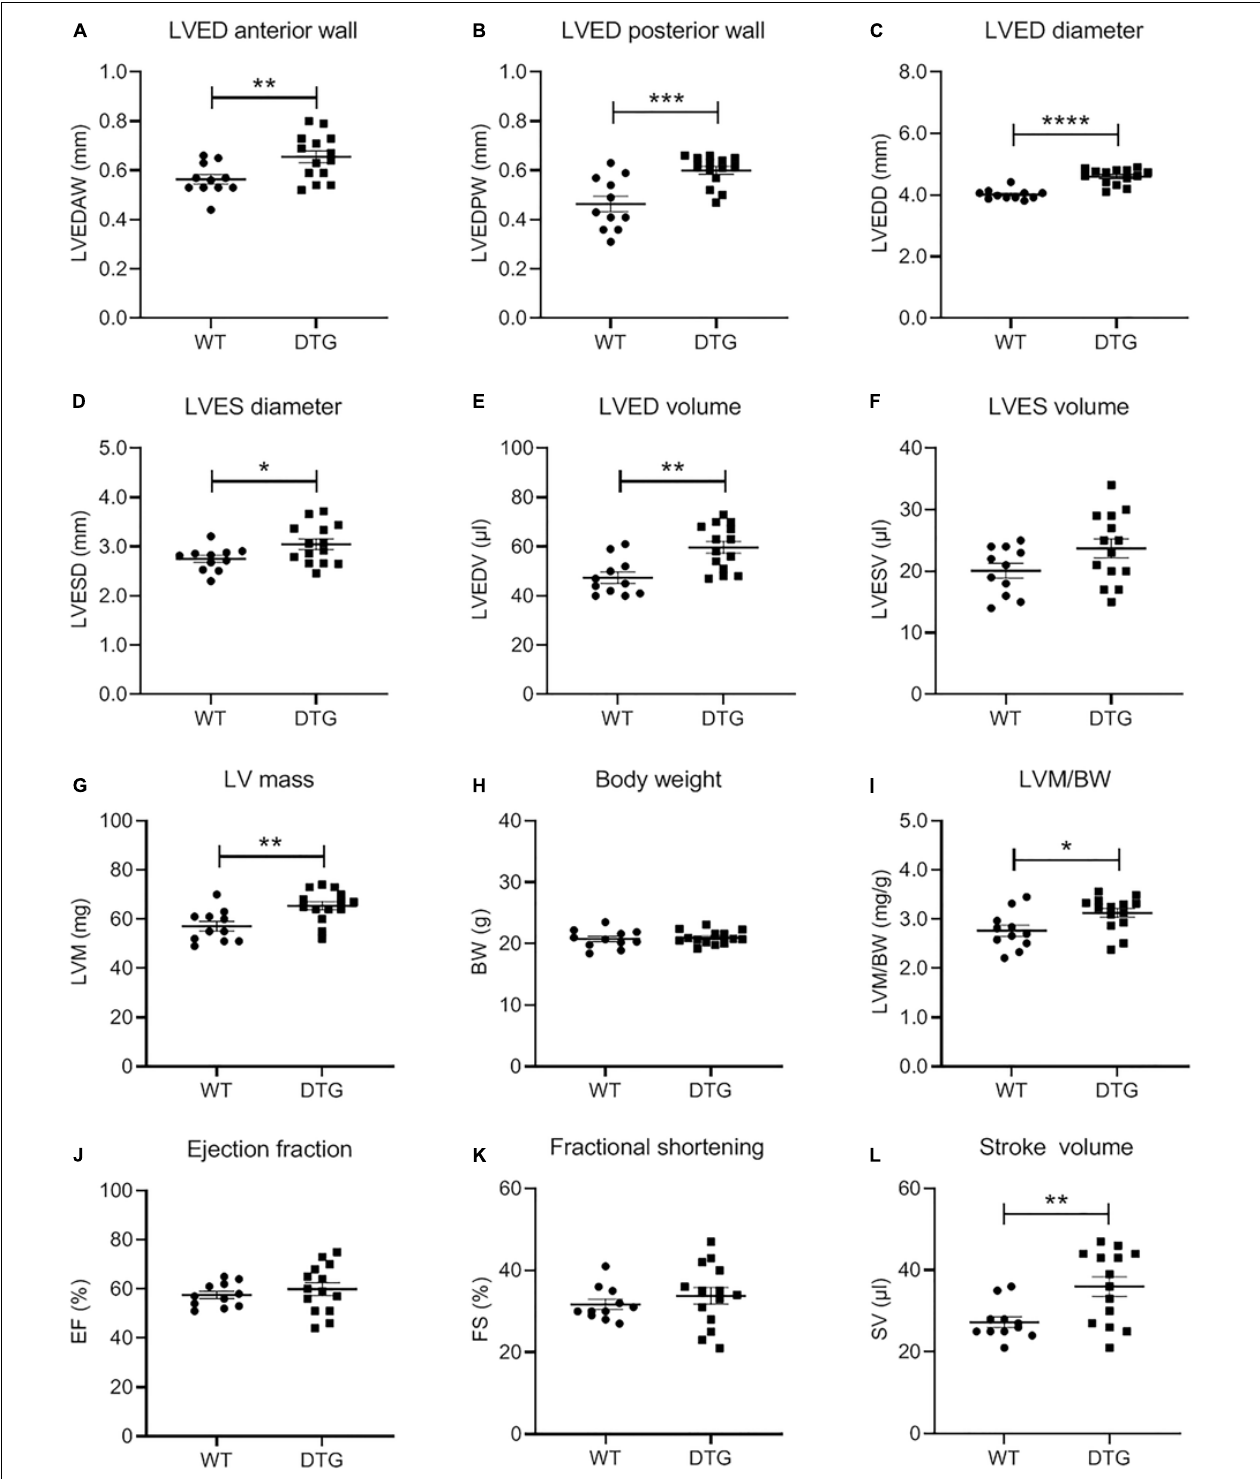
FIGURE 1 | Evaluation of morphological and functional parameters of the heart of DTG and WT mice. Scatter plots show the difference in (A) left ventricular (LV) end-diastolic (ED) anterior wall thickness (LVEDAW), (B) LVED posterior wall thickness (LVEDPW), (C) LVED diameter (LVEDD), (D) LV end-systolic (ES) diameter (LVESD), (E) LVED volume (LVEDV), (F) LVES volume (LVESV), (G) LV mass (LVM), (H) body weight (BW), (I) LVM/BW, (J) ejection fraction (EF), (K) fractional shortening (FS), and (L) stroke volume (SV) of DTG and WT mice. Data are presented as mean ± SEM with * p < 0.05, ** p < 0.01, *** p < 0.001, and **** p < 0.0001 vs. WT, unpaired Student’s t -test. N =